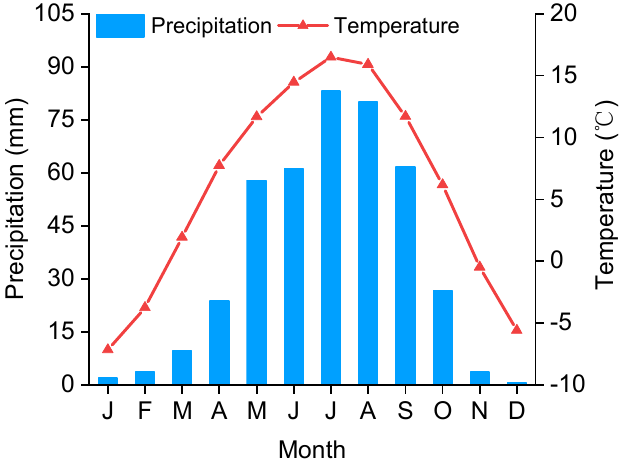
Figure 3. Monthly mean temperature and precipitation over the period 1958–2013 derived from Tongren meteorological station.